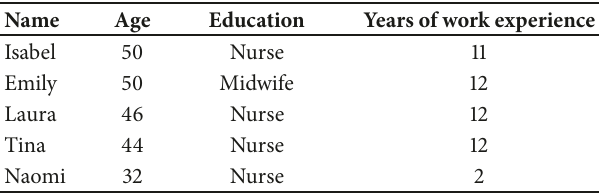
Table 1: Participant